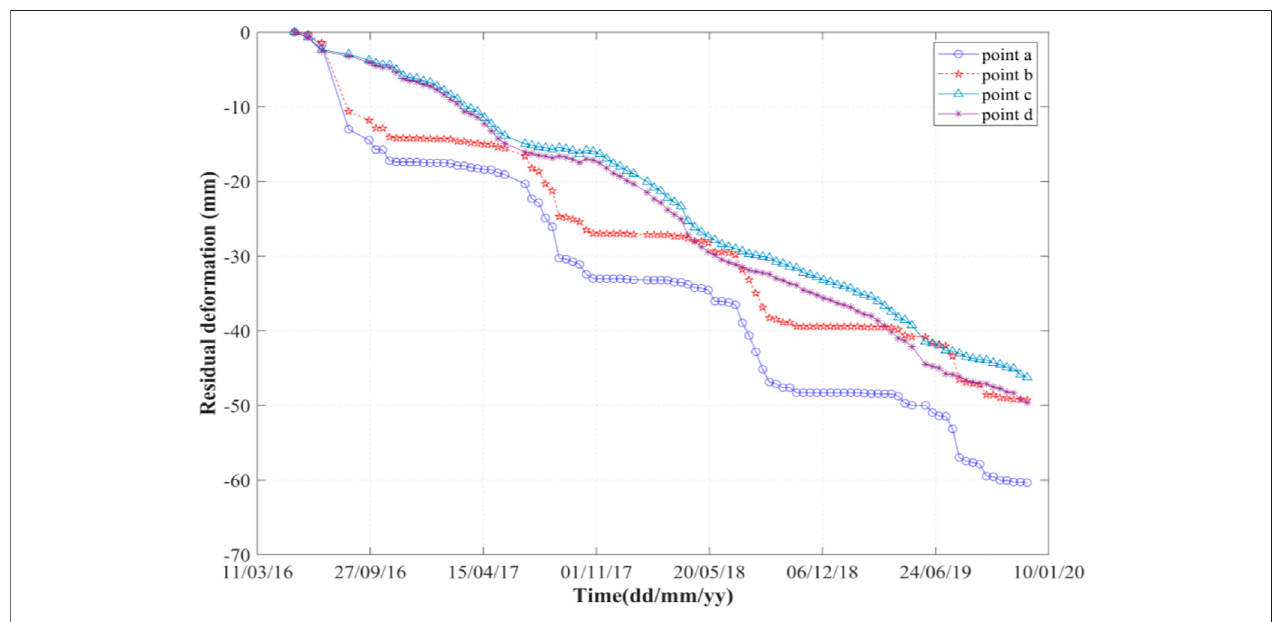
FIGURE 5 | Deformation time series of the feature